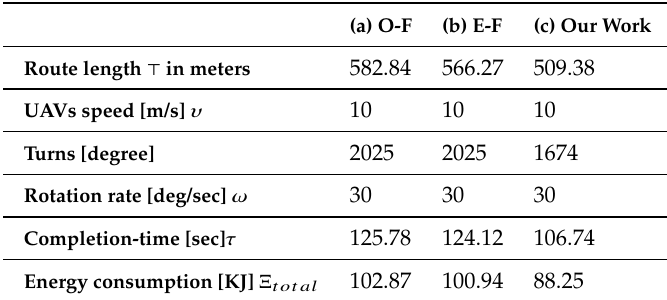
Table 13. CPP path provided in Ref. [16] vs. our CPP.